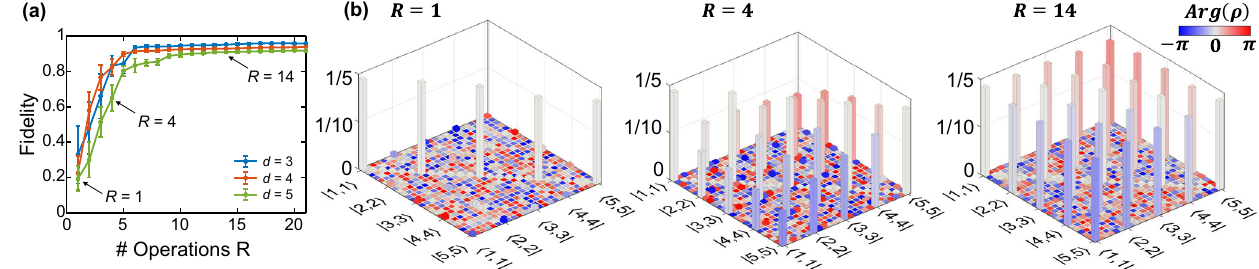
fi rst R ∈ {1,4,14} random operations are considered; their corresponding fi delities aremarked byarrowsin( a ).Shading indicatesthe phaseaccording to the colorbar scheme shown (here and in the following fi gures).